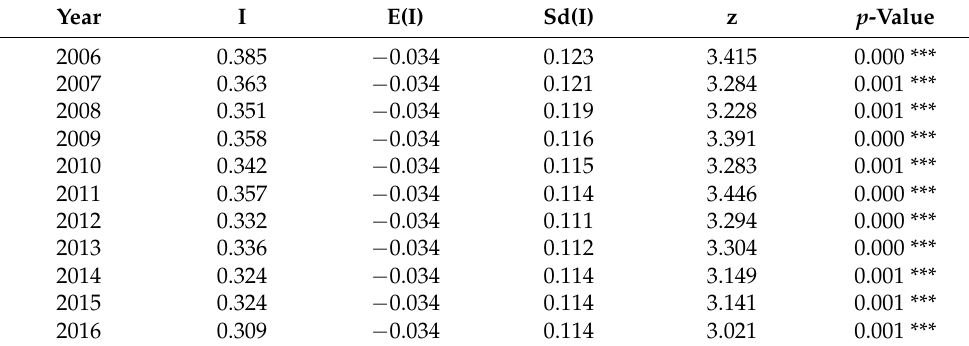
Table 3. Regional Moran’s I index of carbon emissions